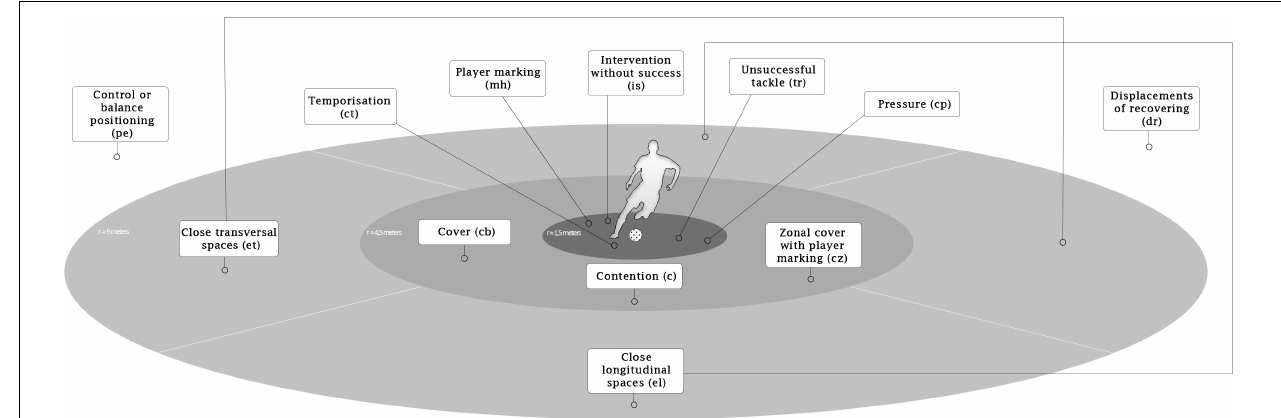
FIGURE 1 | Tactical–technical defensive actions according to distance. The distance and area associated with the tactical and technical behaviours correspond to the ellipse or background’s colour in which they are pointed. However, distance is only one criterion to assess the behaviour. For example, in the “close transversal spaces,” the defender should be positioned to the side and facing the ball carrier, and in the “close longitudinal spaces,” the defender should be placed to the front and facing the ball carrier. For more details, see Fernandes (2017).